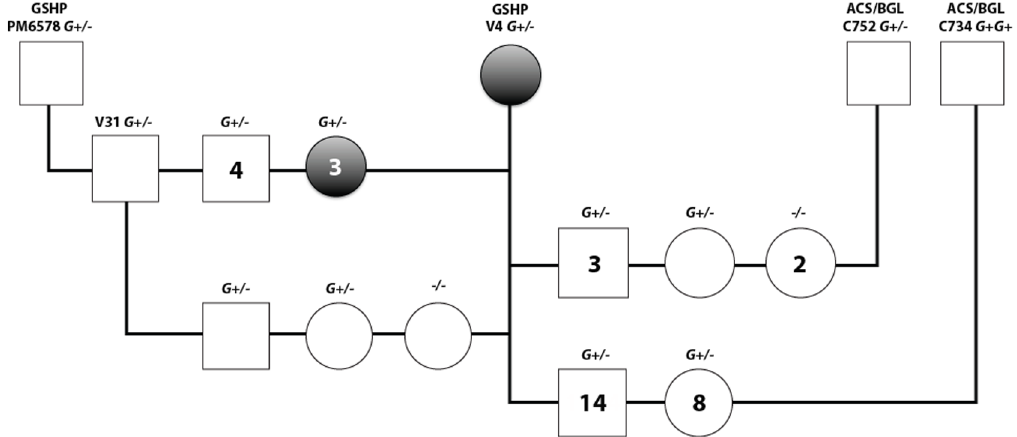
Fig 3. Embryoniclethality in association with the homozygous insertion at CFA9:6048201was identified in breeding experiments. At left are crossesbetweenV4, a fertileGSHP XX DSD andGSHP males(PM6578,V31). At right are crossesbetweenV4 andmalesfrom the XX DSD modelpedigree(C752,C734),whichvary in proportionof Americancockerspanielandbeaglegeneticbackground (ACS/BGL). Genotypesat the insertionlocus(CFA9:6048201) are homozygous ( G+G+ ), heterozygous ( G+/- ),or wildtype ( -/- ).Femalesare indicatedby opencircles,XX DSD by filledcircles, andXY malesby squares.Each symbolrepresentsonedog, exceptthosecontaininga number,which indicatesthe numberof dogsrepresentedby that symbol. Noneof the offspringhadthe G+G+ genotype.Basedon simpleMendelianinheritance, the expectednumberof -/- , G+/- and G+G+ offspringfrom the G+/- sires anddamsis 4.25, 8.5, and4.25, respectively(N = 17). This is significantly differentfrom the numbersobserved( x 2 = 8.1776,df = 2, Chi-squaredtest is significant at p < 0.025since8.1776 > 7.38). Similarly,the expectednumberof G+/- and G+G+ offspringfrom a G+/- dam and G+G+ sire (V4 x C734)is 11 and11, respectively (N = 22). This is a highlysignificant differencefrom the numbersobserved( x 2 = 20.04, calculationsincludecontinuitycorrectionfor df = 1 [45];Chi-squared test is significant at p < 0.005since20.04 > 7.88). Sinceall offspringof C734( G+G+ )must havereceivedthe G+ allele from him, onlythosereceivingthe wildtype allelefrom the GSHP V4 dam( G+/- )wereborn. Together,